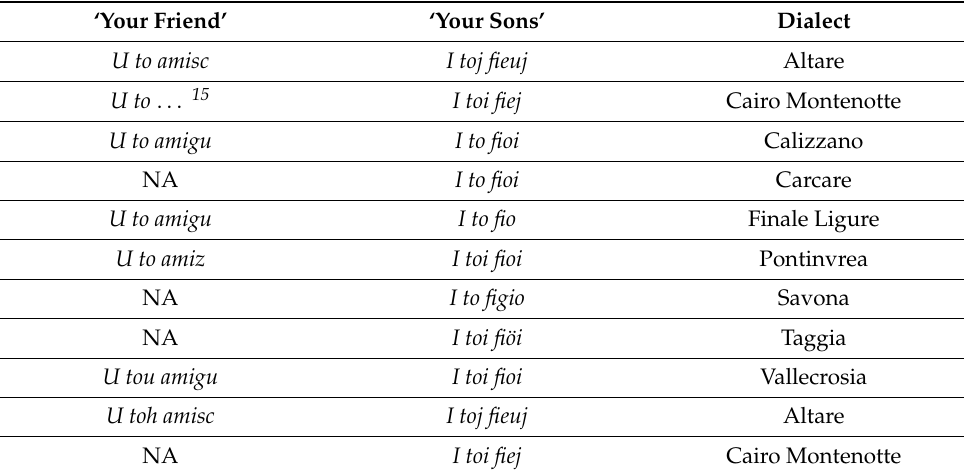
Table 11. Possessives in singular and plural DPs (Source: ASIt). Inflected forms are in bold. ‘Your Friend’ ‘Your Sons’ Dialect U to amisc I toj fieuj U to . . .